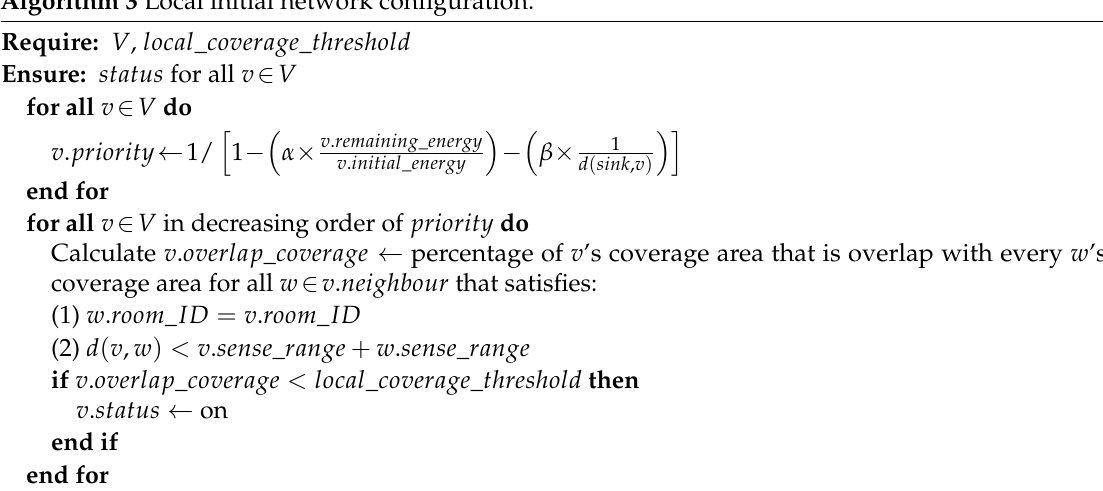
Algorithm 3 Local initial network